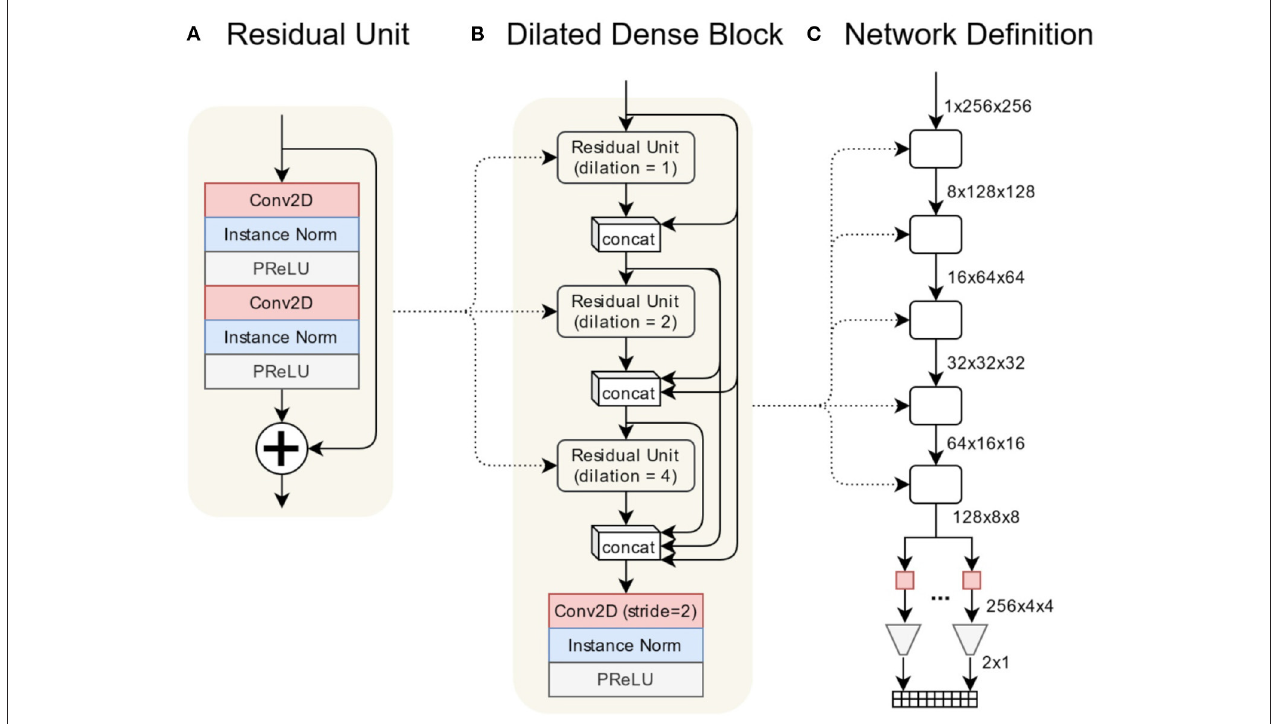
FIGURE 2 | The valve estimation network is composed primarily of a series of densely-connected convolutional layers. Each dense block is composed of three residual units containing 2D convolutions using progressively larger dilation rates. A final convolution reduces the spatial dimension of the volume by 2. The regression network is implemented as a sequence of densely-connected blocks followed by a series of small fully-connected networks relating the final output volume to each landmark coordinate. (A) Residual unit, (B) dilated dense block, (C) network